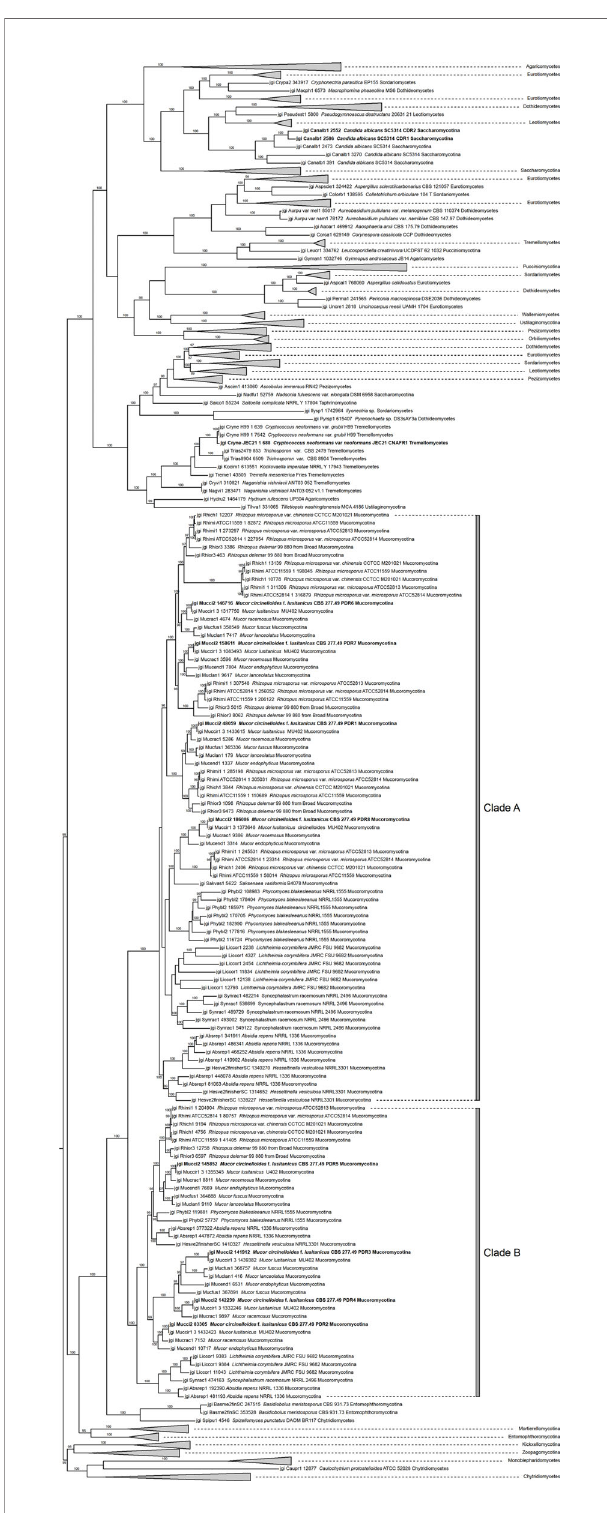
FIGURE 1 | Phylogenetic tree of PDR proteins inferred from 853 amino acid sequences using Maximum Likelihood method. The eight M. circinelloides Pdr proteins, C. neoformand CnAfr1 and the C. albicans Cdr1 and Cdr2 are indicated with bold characters. Numbers above or below branches are ultrafast bootstrap supports. Only values greater than 95% are